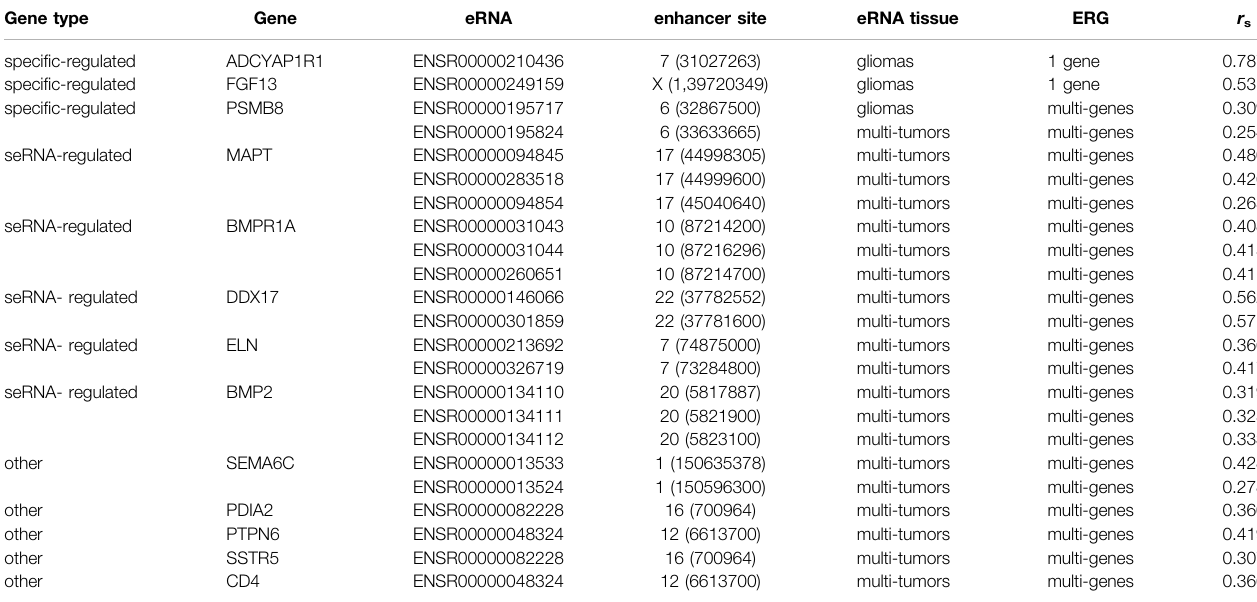
TABLE 1 | The correlation analysis for eRNA and their target